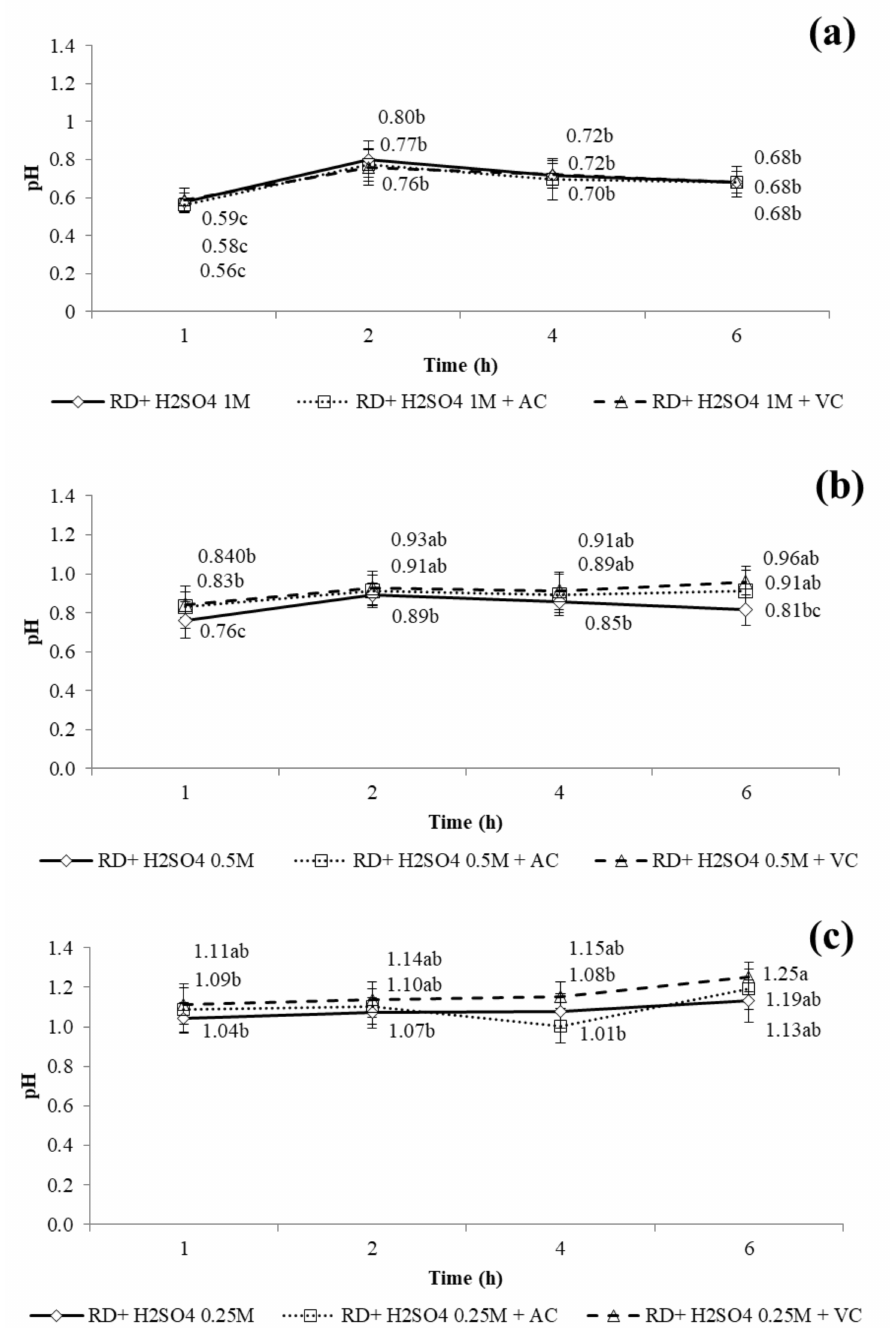
Figure 3. pH evolution in samples with H 2 SO 4 1 M, (3.a); H 2 SO 4 0.5 M (3.b) and H 2 SO 4 0.2 5M (3.c). Values in dot for each hour followed by the same letter are not significantly different ( p = 0.05) using the Duncan test with a R 2j = 0.76 ( a ), R 2j = 0.84 ( b ) and R 2 = 0.81 ( c ). Error bars indicate standard errors of the mean (n =